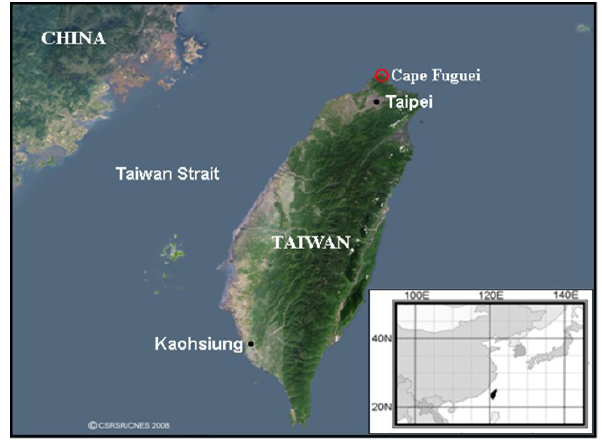
Figure 1. The geographical location of the CAFÉ research sta- tion (25.30 ◦ N, 121.54 ◦ E), which is at the northern tip of Taiwan in eastern Asia. The digital map is provided by Center for Space and Remote Sensing Research, National Central University, Taiwan (©